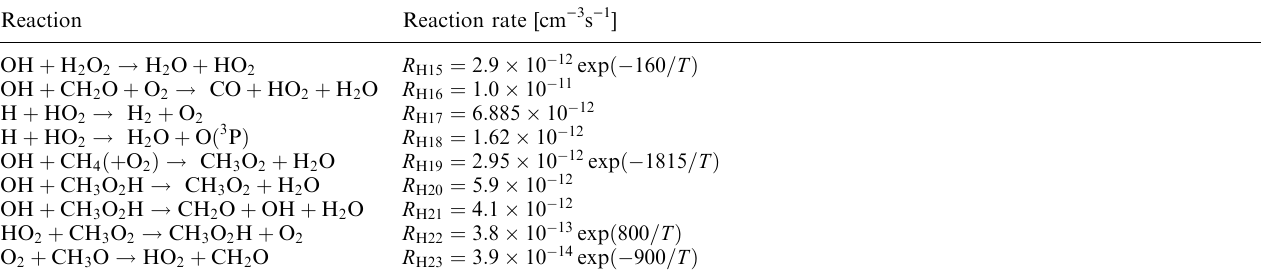
B. Steil et al.: Development of a chemistry module for GCMs: first results of a multiannual Table 2. (contd) Reaction